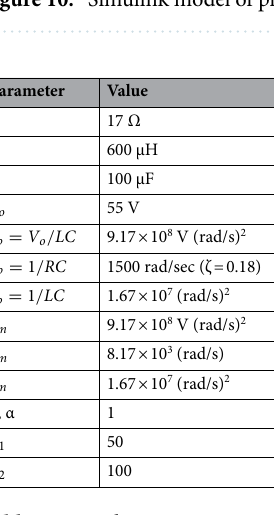
Table 2. Simulation parameters for the proposed